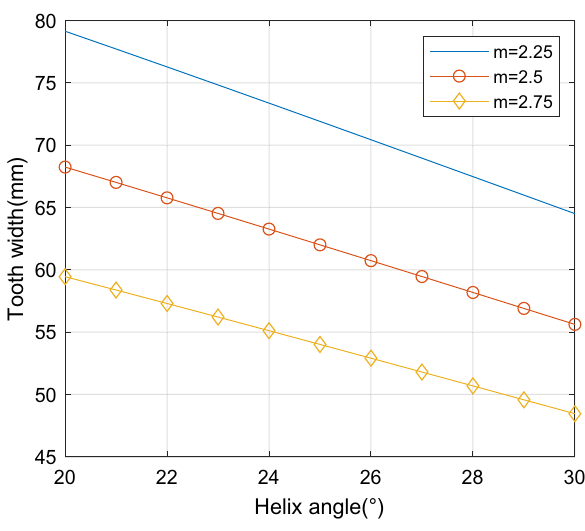
Fig. 16 Tooth width value of different modulus and helix angle at equal bending strength of the teeth and pressure angle of 20°